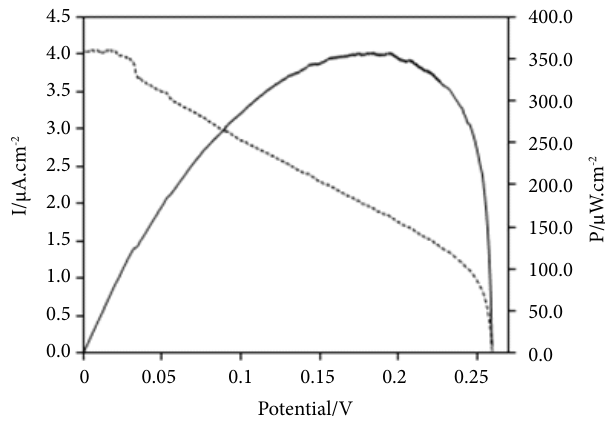
Fig. 2: Polarization curve of BFC with bioanode GC/PMG/HOOC- MWCNT/PDDA/ADH/PDDA and Pt –C cathode in oxygen saturated